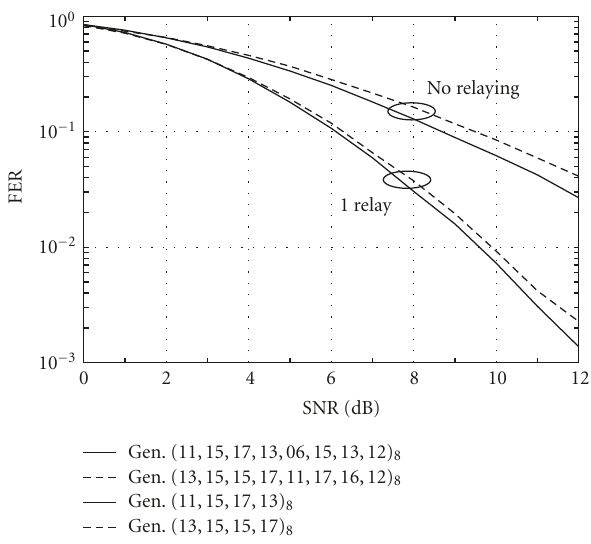
Figure 9: QPSK, 8 states ( μ = 4), generators as in Table 5, various number of relaying nodes, 1 transmitting antenna per node, 1 receiving antenna, in quasistatic fading